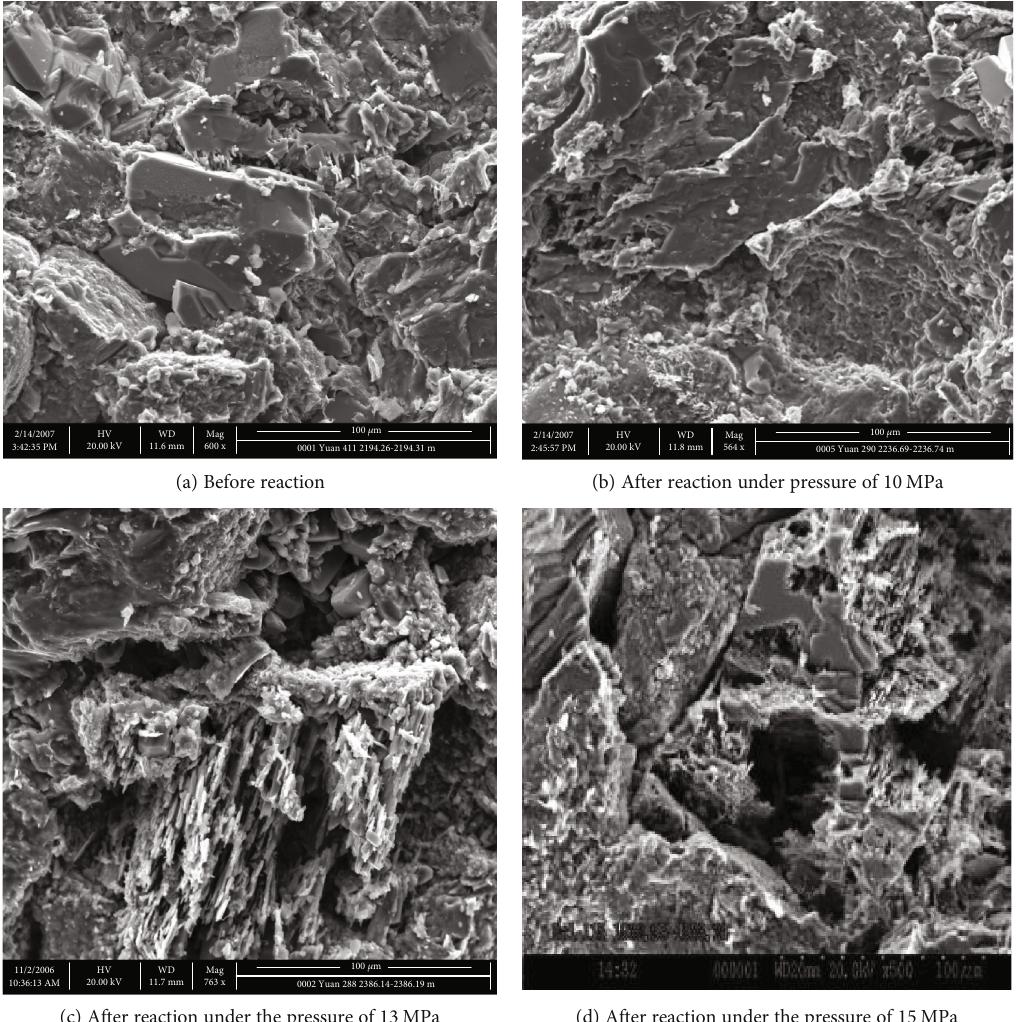
Figure 14: SEM pictures of rocks before and after interactions with CO